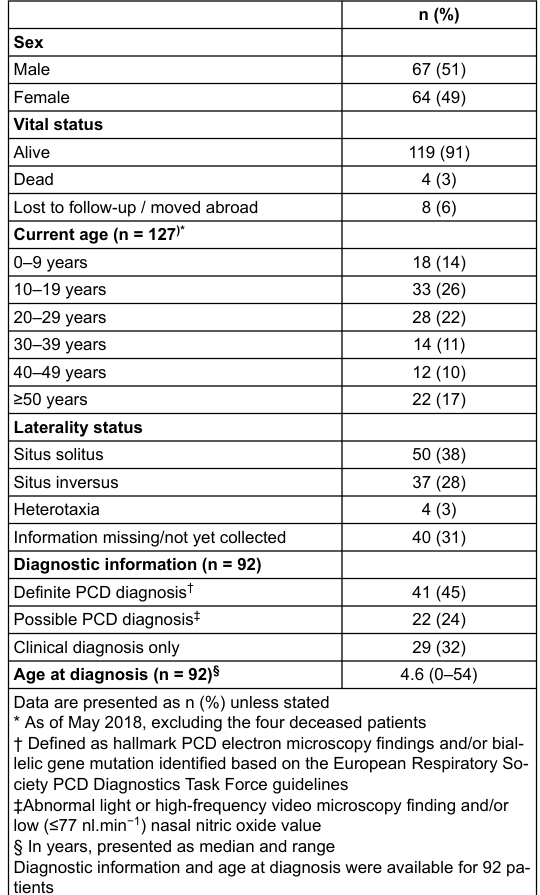
Table 3: Basic characteristics of PCD patients currently included in the Swiss PCD Registry (n =